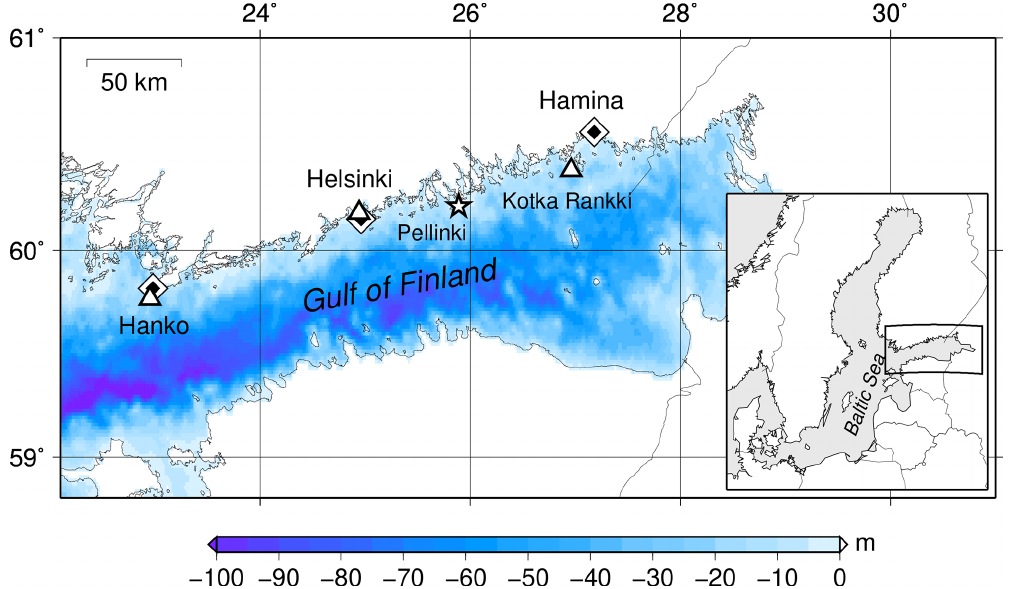
Figure 1. Bathymetric map of the study area, the Gulf of Finland in the Baltic Sea. Locations of the Finnish tide gauges are marked with diamonds. Meteorological stations, which provided the data used in this study, are marked with triangles. The star denotes the site of the eyewitness observation quoted in the